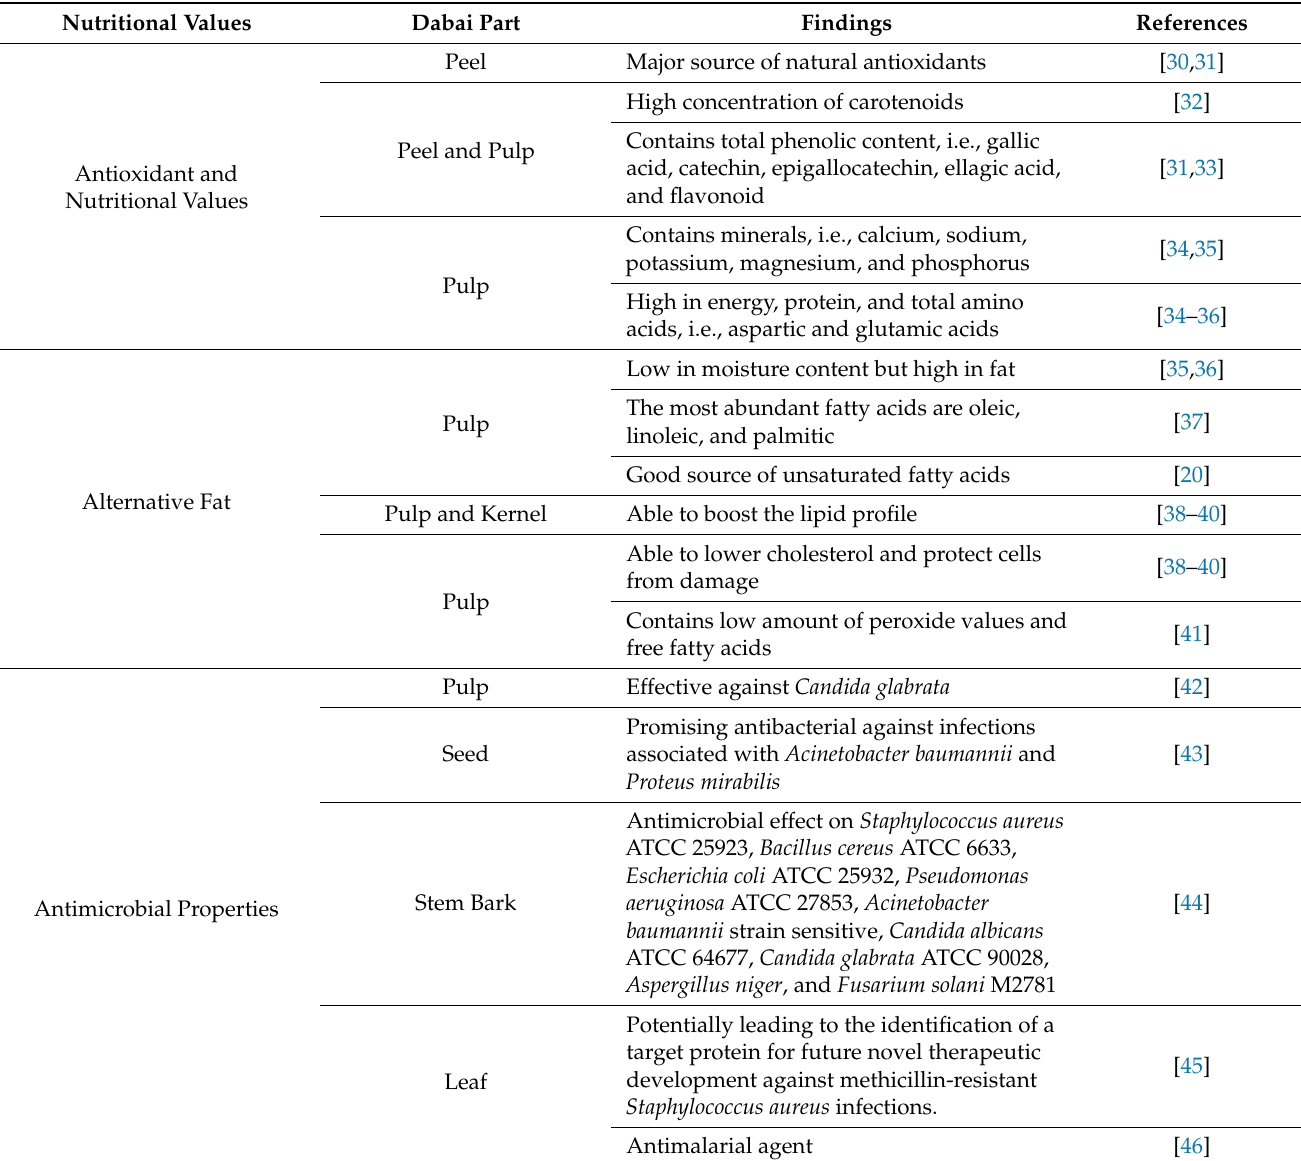
Table 1. Nutritional values of